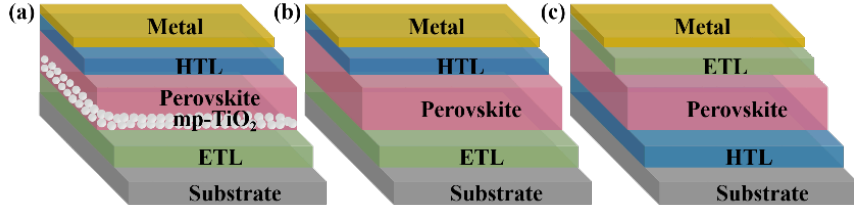
Figure 2. Three representative structures of PSCs: ( a ) mesoporous structures; ( b ) regular planar (n- i-p) structures, and ( c ) inverted planar (p-i-n) structures.